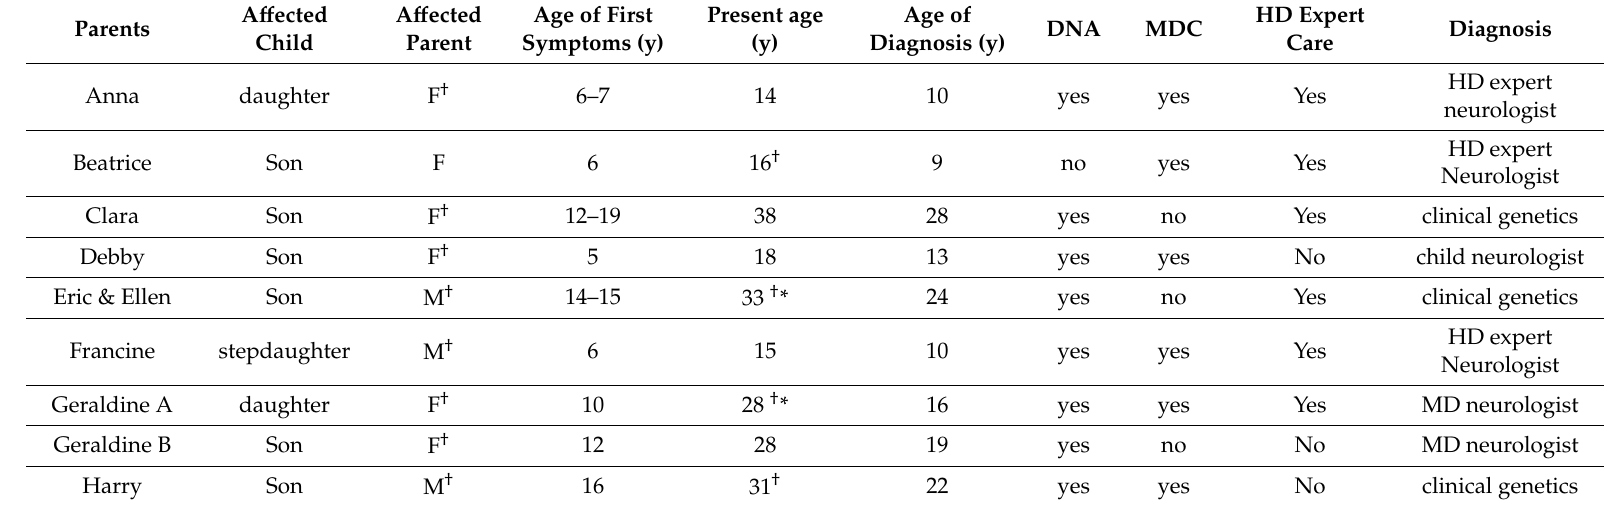
Table 1. Clinical characteristics of juvenile Huntington’s disease (JHD)